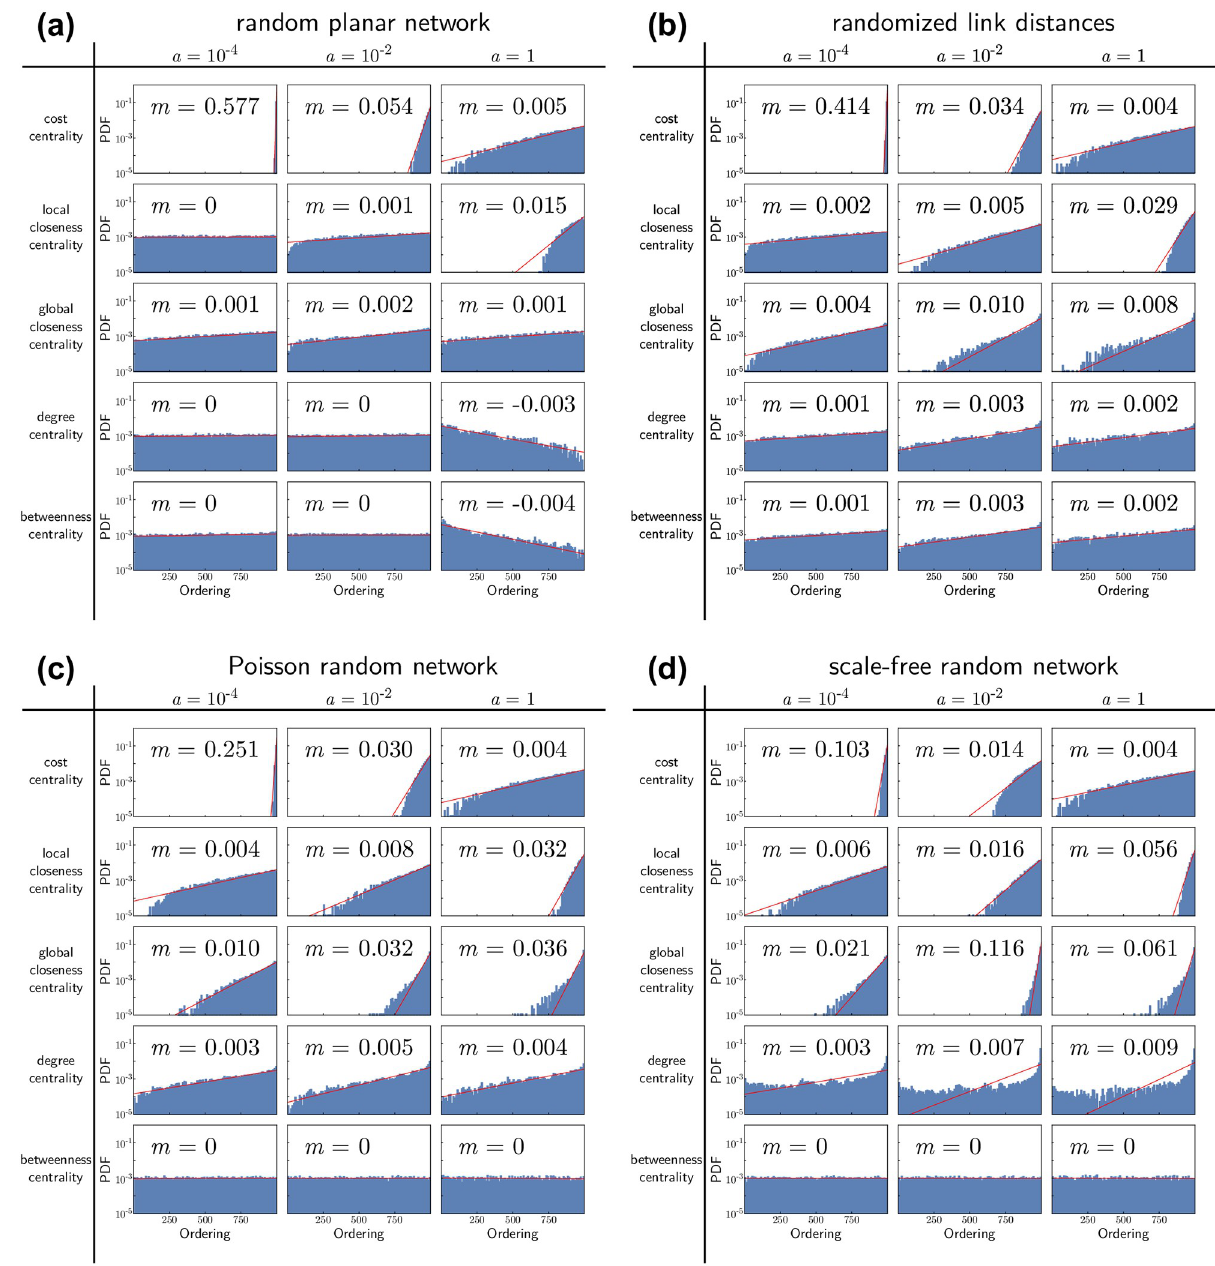
Fig 4. How to become the central supplier? Distribution of the ranking of the final supplier in various centrality measures (see main text) in (a) a random planar network, (b) the network with a random permutation of edge distances, (c) a Poisson random network with a random permutation of the edge distances, and (d) a scale-free network with a random permutation of the edge distances. All networks are constructed from a Delaunay triangulation of N = 1000 points uniformly randomly distributed in the unit square, resulting in M = 3000 links with distances equal to the Euclidean distance between the connected nodes (see Methods for